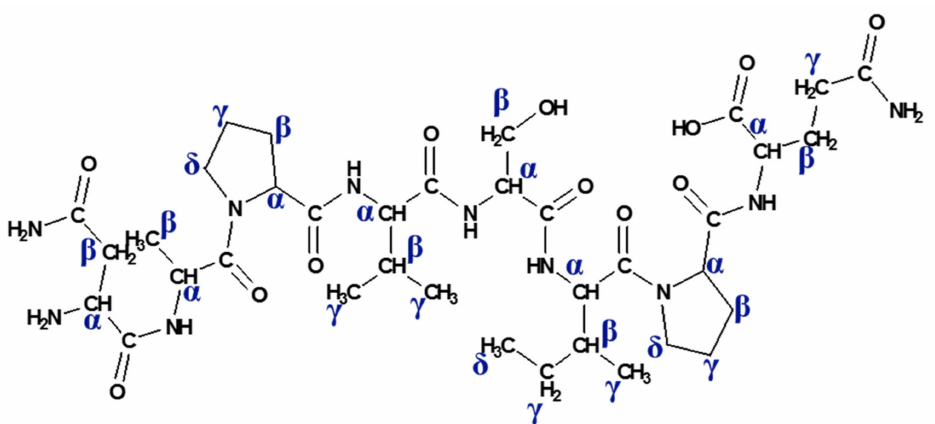
Figure 3. Two-dimensional structure of native NAP peptide (Asn-Ala-Pro-Val-Ser-Ile-Pro-Gln) with